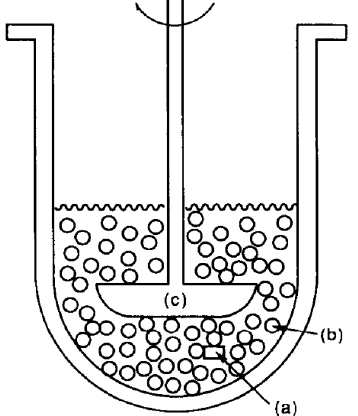
Figure 9. Schematic of the paddle-bead method. Reprinted from Reference [68] with permission from Elsevier. Explanation of letters as stated by the authors: ( a ) matrix tablet, ( b ) polystyrene beads, ( c )